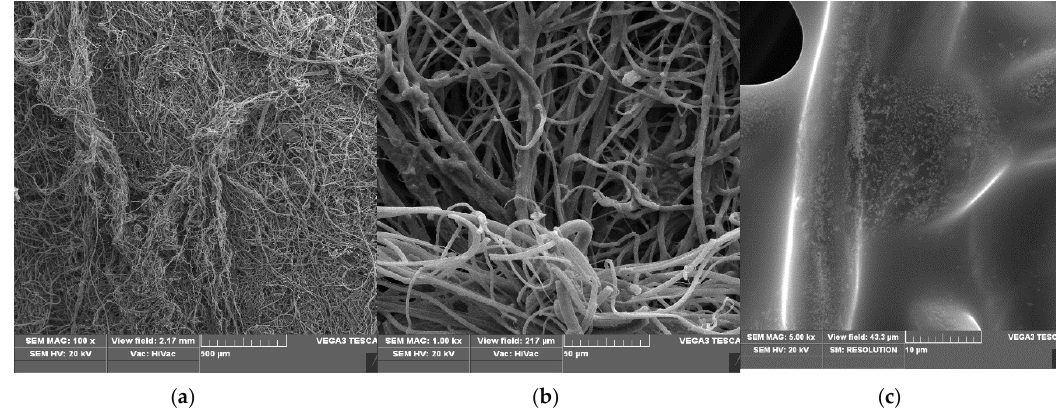
Figure 7. SEM images of PLA-SM-KI (2%) composite, magnification: 100× ( a ); 1000× ( b ) and 5000× ( c ). ( a ) (PLA-SM-KI (2%); SEM mag.×100). ( b ) (PLA-SM-KI (2%); SEM mag.×1000). ( c ) (PLA-SM-KI (2%); ( a ) (PLA-SM-KI (2%); SEM mag. × 100). ( b ) (PLA-SM-KI (2%); SEM mag. × 1000). ( c ) (PLA-SM-KI (2%); SEM mag.×5000). SEM mag. ×